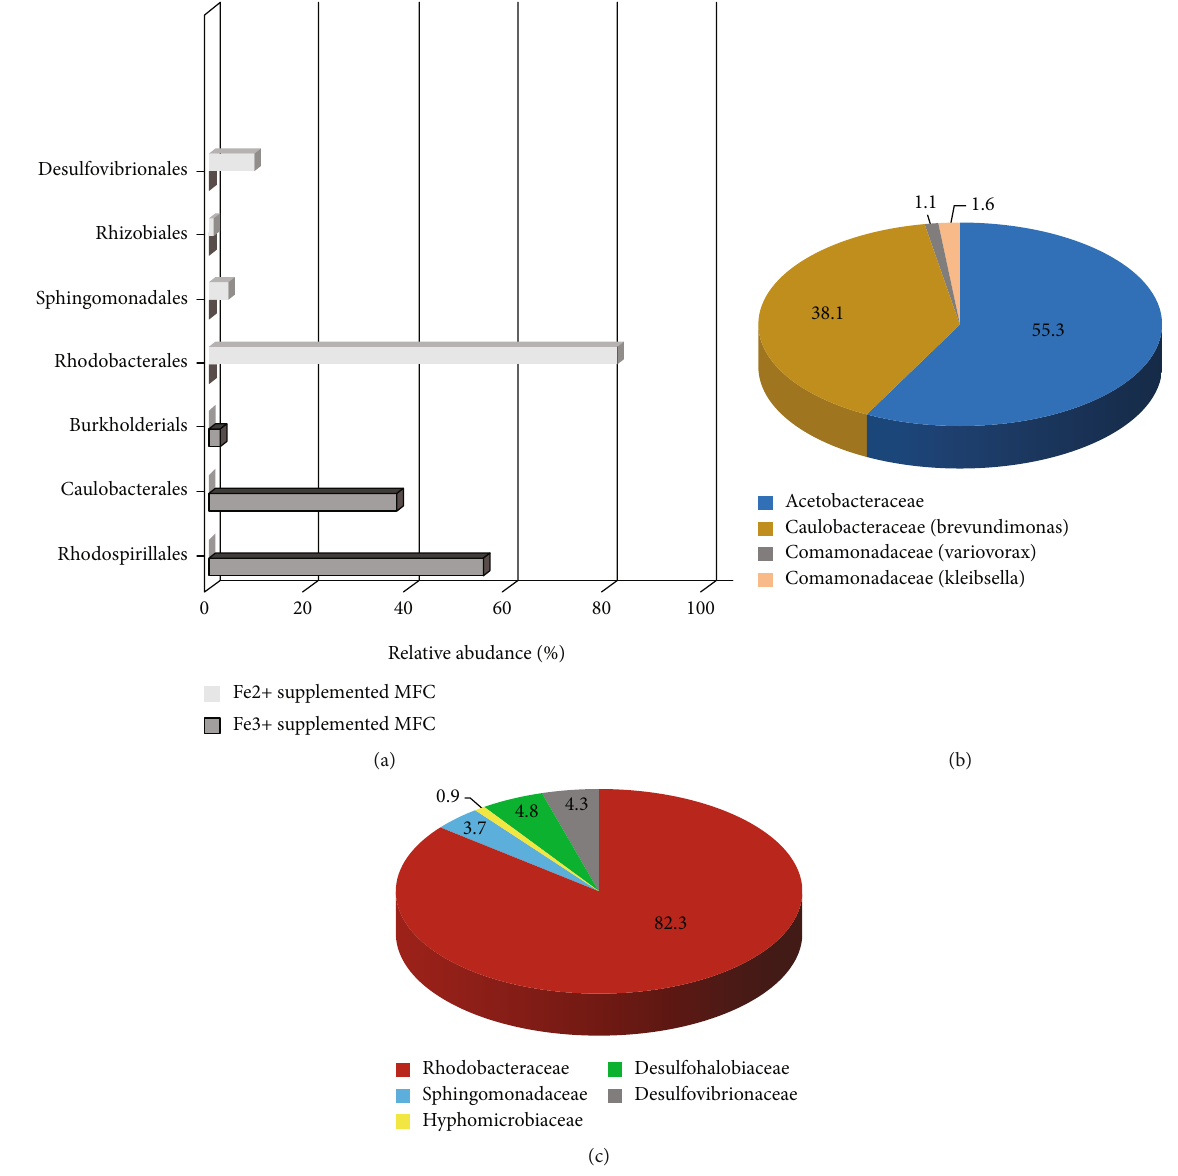
Figure 4: Microbial population distribution: (a) at the order level, comparison of the di ff erent microbial groups in both MFCs; (b) at the family level in the MFC supplemented with Fe 3+ ; (c) at the family level in the MFC supplemented with Fe 2+